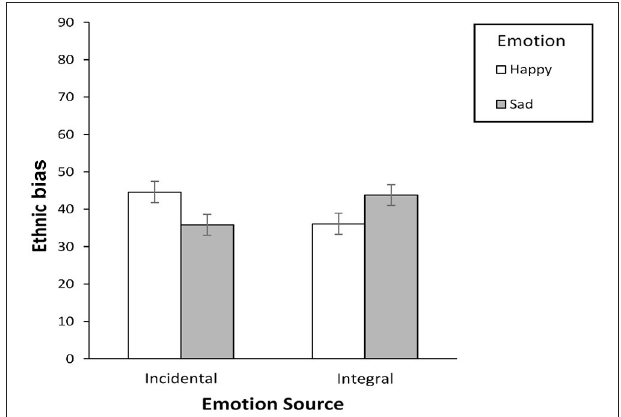
FIGURE 2 | Divergent pattern of effects obtained for positive and negative incidental-non-applicable and integral-non-applicable emotions on interethnic bias consistent with Prediction 1 (Experiment 1; N = 93 White Australian students in face-to-face contact with ethnic tutor in their classroom). Graph includes error bars as